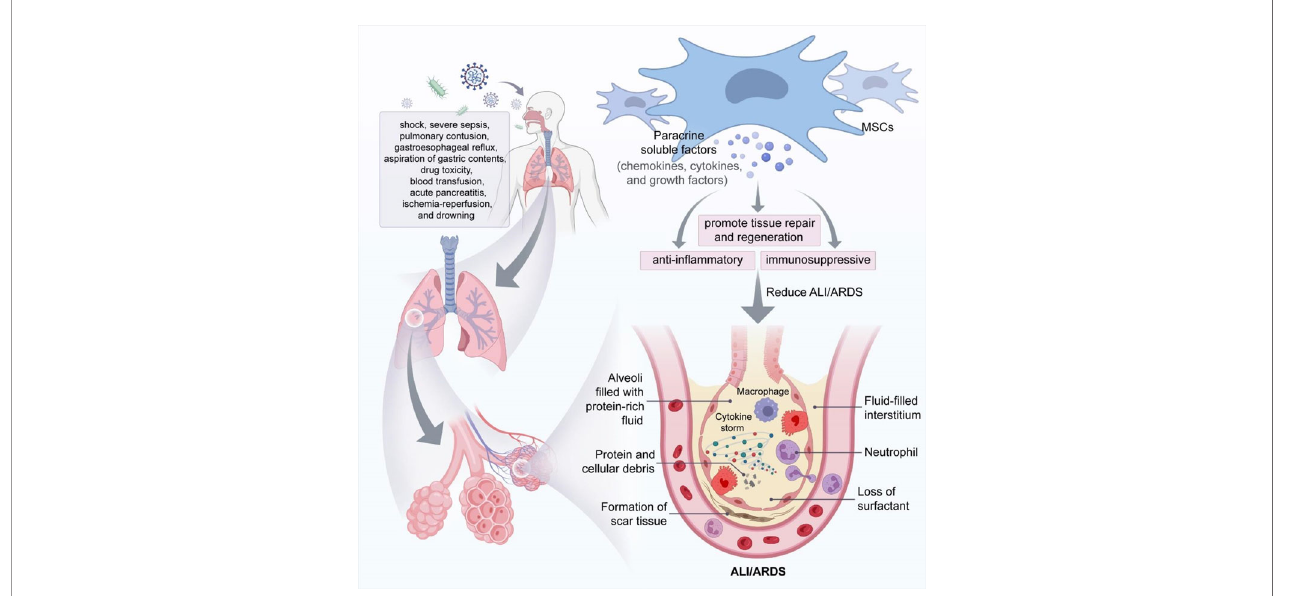
FIGURE 2 | MSCs attenuate ALI/ARDS through paracrine soluble factors. In the phase of ALI/ARDS, immune cells (e.g., macrophages and neutrophils) accumulate in the alveolar space and produce large amounts of cytokines, leading to a cytokine storm that will eventually cause decreased surfactant from alveolar epithelial cells and fl uid accumulation in the alveolar space and interstitium, resulting in alveolar and pulmonary interstitial edema, and MSCs can play a key role in mitigating ALI/ ARDS through the immunomodulatory effects of paracrine soluble factors.